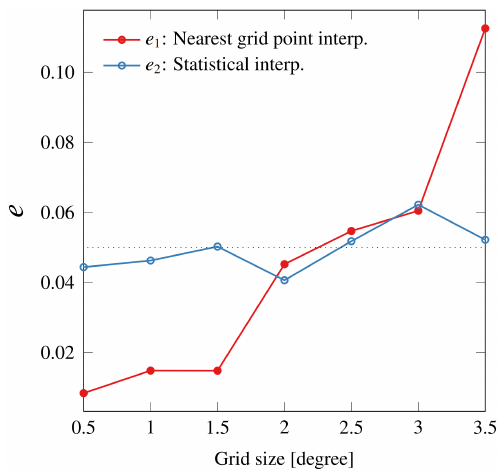
Figure 8. The errors of different grid sizes and